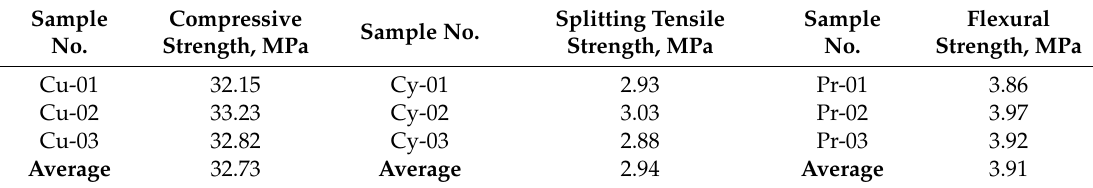
Figure 4. Testing hardened concrete specimens. Table 2. Hardened concrete tests.